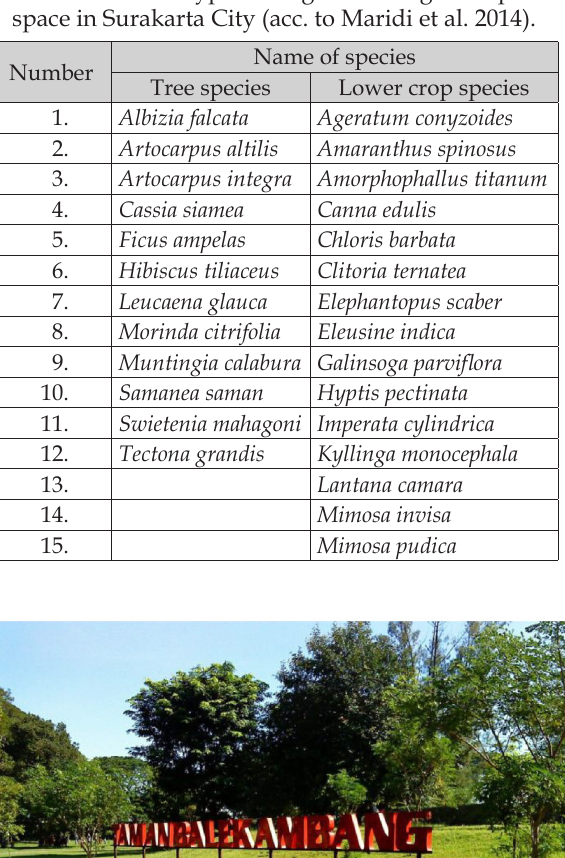
2. Various types of vegetation in green